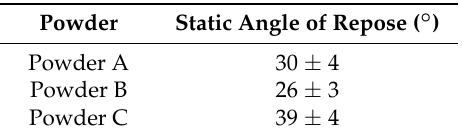
Table 4. Static angle of repose of particles A, B, and